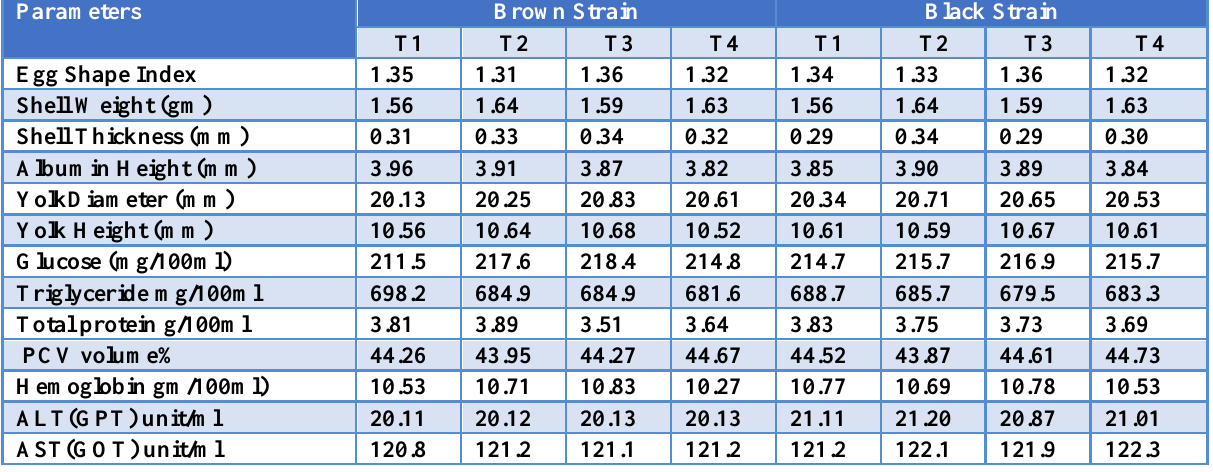
Table, 5: Effect of treatments in egg quality and some blood parameters for brown and black quail